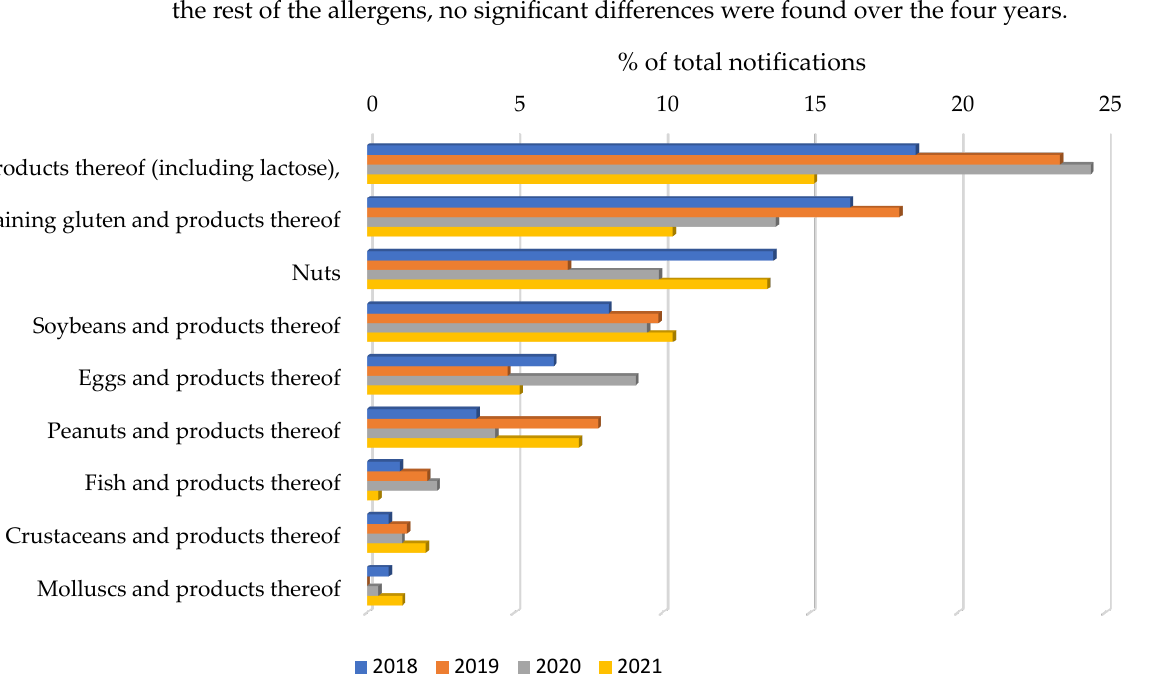
Figure 4. Statistical differences among the undeclared, main pediatric allergens in notifications emit- ted between 1 January 2018 and 31 December 2021. In grey- no significant differences; in yellow- sig- nificant differences with p < 0.01; in orange - significant differences with p < 0.005; and in brown- significant differences with p < 0.001.